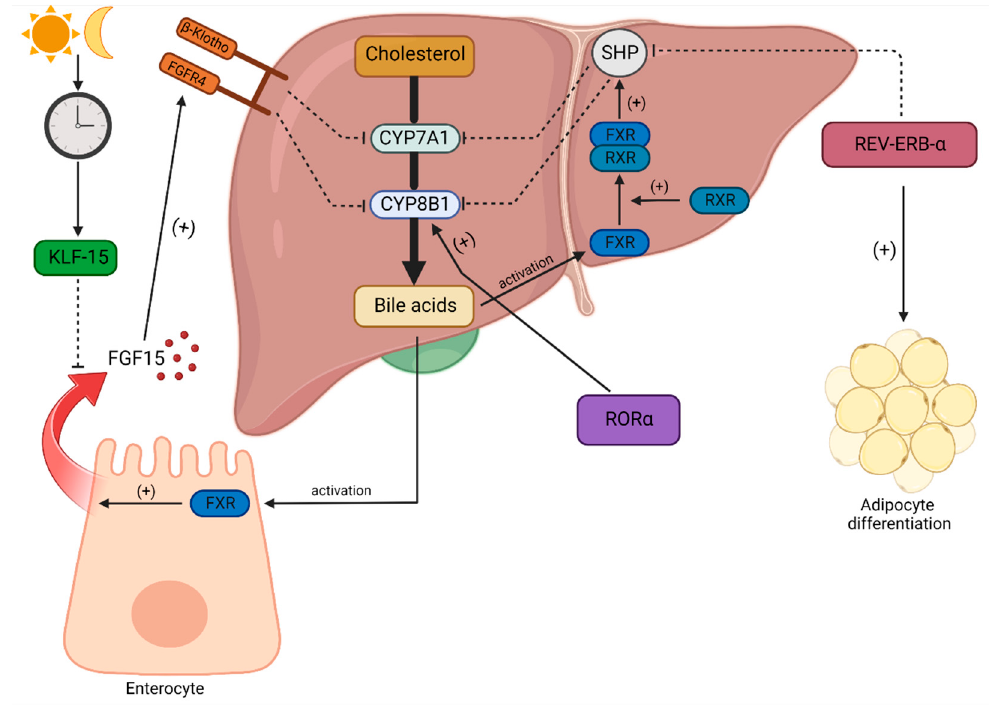
Figure 2. Impact of the circadian clock on lipid and bile acid homeostasis. Cholesterol is converted into bile acids in the biochemical pathway in hepatocytes. The main enzymes of this pathway are cholesterol 7 alpha-hydroxylase (CYP7A1) and sterol 12-alpha-hydroxylase (CYP8B1). CYP8B1 is stimulated by one of the circadian clock proteins, orphan receptor α (ROR α ). The production of bile acids is regulated by a negative feedback loop. Bile acids activate the nuclear farnesoid X receptor (FXR). It binds to the retinoid X receptor (RXR) and forms a heterodimer. The FXR-RXR complex activates a small heterodimer partner (SHP). The SHP protein inhibits CYP7A1 and CYP8B1 enzymes and decreases the production of bile acids. The circadian clock can influence the bile acid synthesis pathway via SHP. Specifically, REV-ERB- α inhibits SHP. Thus, REV-ERB- α promotes bile acid synthesis. Moreover, it stimulates adipocyte differentiation. Some bile acids are transported into the small intestine. They activate the FXR in enterocytes, resulting in the release of fibroblast growth factor 15 (FGF15). FGF15 promotes the fibroblast growth factor receptor-4/ β - Klotho (FGFR4/ β -Klotho) complex, inhibiting CYP7A1 and CYP8B1. This is the second negative feedback loop regulating bile acid synthesis. Day and night cycles can influence bile acid synthesis via the circadian regulation of Krupple-like factor 15 (KLF15) production. KLF15 restrains